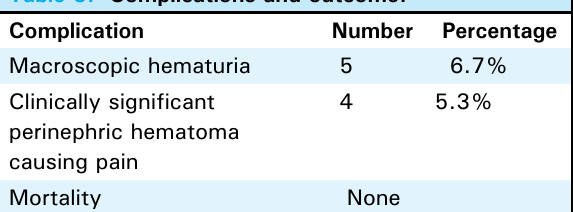
table 5. complications and